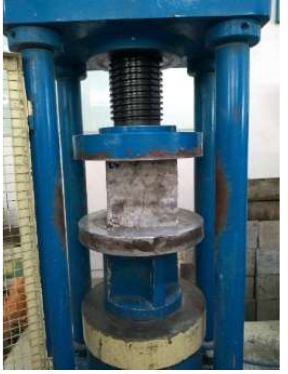
Figure 2. Typical setup of UTM for compressive test.